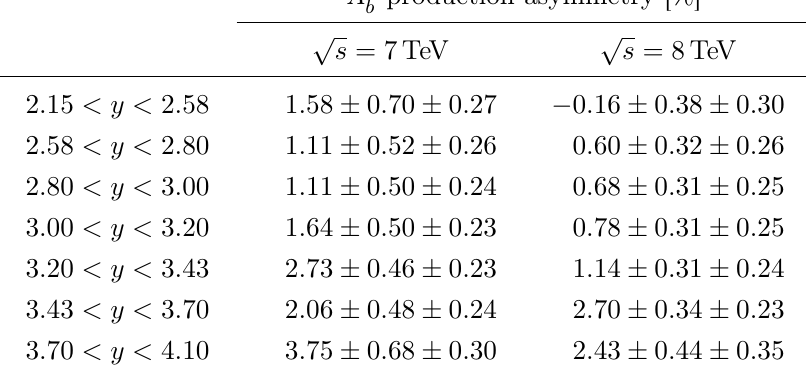
Table 4 . Measured (cid:3) 0 production asymmetry in rapidity intervals. Values are given in percent. b The first uncertainty is statistical, the second systematic. The uncertainties are partially correlated between rapidity intervals.